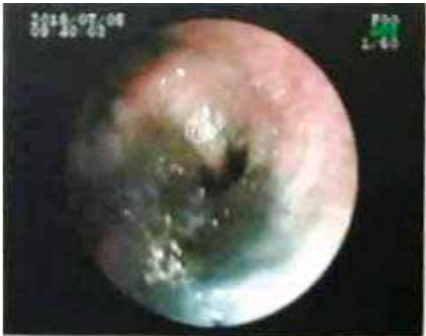
Figure 2: Bronchoscopy view of airway